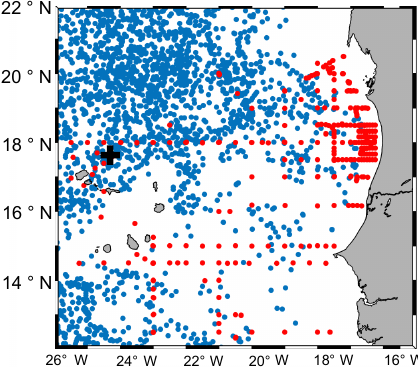
Figure 3. Locations of available temperature and salinity profiles obtained in the TANWA between 1995 and 2013. Red dots mark shipboard CTD stations, blue dots locations of Argo float profiles, and the black cross the location of the CVOO